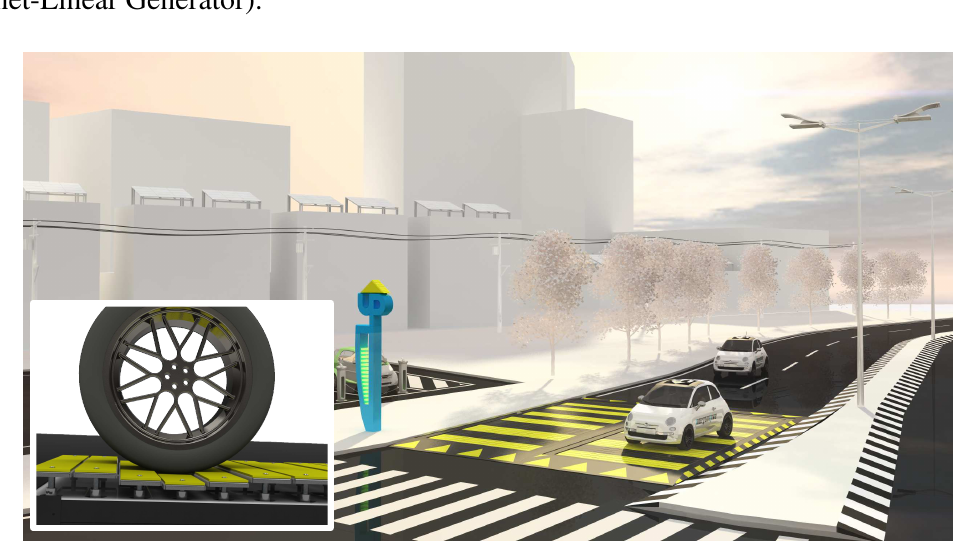
Figure 1. Future scenario of vehicles’ energy harvesting system in Smart Cities (inset: simplified diagram of a speed-bumper energy converter with Tubular Permanent Magnet-Linear